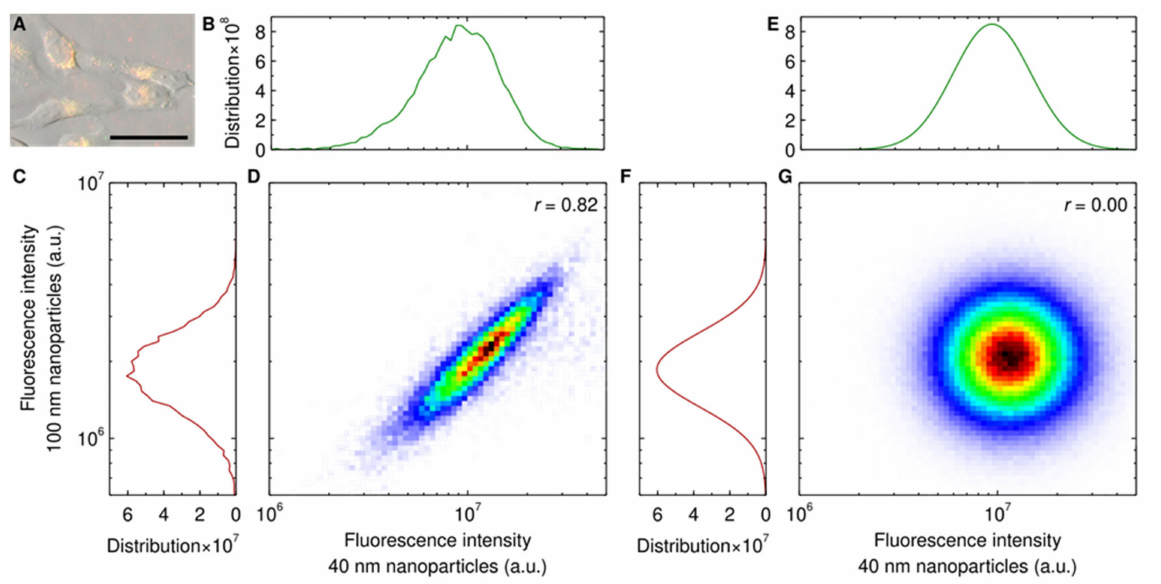
Figure 3. Uptake of the 40 and 100 nm particles at individual cell level. ( A – D ) Experimental results. Cells were exposed for 24 h to both the 100 nm (20 µ g/mL; 0.060 nM) and 40 nm (100 µ g/mL; 4.7 nM) particles simultaneously (conditions correspond to the highest 40 nm particle concentration in Figure 2 and S3). ( A ) Microscopy of cells. (Grey) Phase-gradient contrast microscopy image showing the contour of the cells. (Red) 100 nm and (green) 40 nm particles. (Yellow) Overlap of the two particles. Note that the fluorescence intensity of the two particles is different; thus, the results cannot be interpreted in absolute terms. Scale bar corresponds to 50 µ m. The results show that cells take up both nanoparticles. ( B – D ) Fluorescence of cells measured using flow cytometry. Distribution of cell fluorescence corresponding to the ( B ) 40 nm and ( C ) 100 nm particles. ( D ) Two- dimensional distribution of the two fluorescences. The results show a strong correlation between a cell having taken up one of the nanoparticles with it having taken up the other nanoparticle. ( E – G ) Theoretical distributions derived from fits to the experimental data (panels ( B – D )). ( E , F ), Log normal distribution fits to the distribution of individual fluorescences (panels ( B , C )). ( G ) Two- dimensional distribution derived under the assumption that the two fluorescences are independent. To evaluate the distribution, 10 6 random samples were drawn from each of the two individual distributions (panels ( E , F )). The simulated results do not show any correlation between a cell having taken up one of the nanoparticles and it having taken up the other nanoparticle, in stark contrast to the experimental results (panel ( D )). We can therefore conclude that experimentally the uptake of one particle is not statistically independent of the uptake of the other. Panels use the same scale